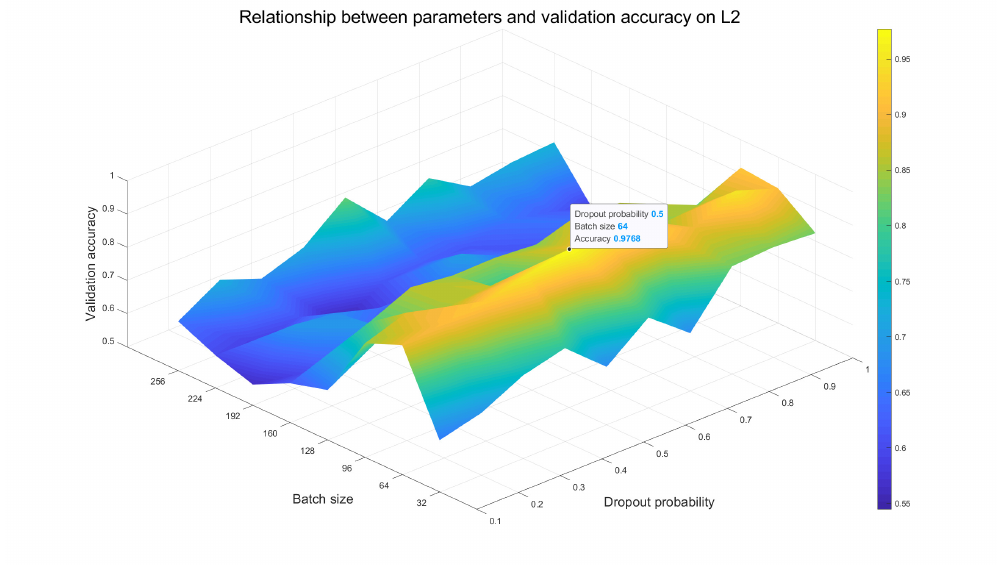
Figure 11. Surface plot on the L2 model displaying the resulting validation recognition accuracy for different choices of values of the batch size and the dropout